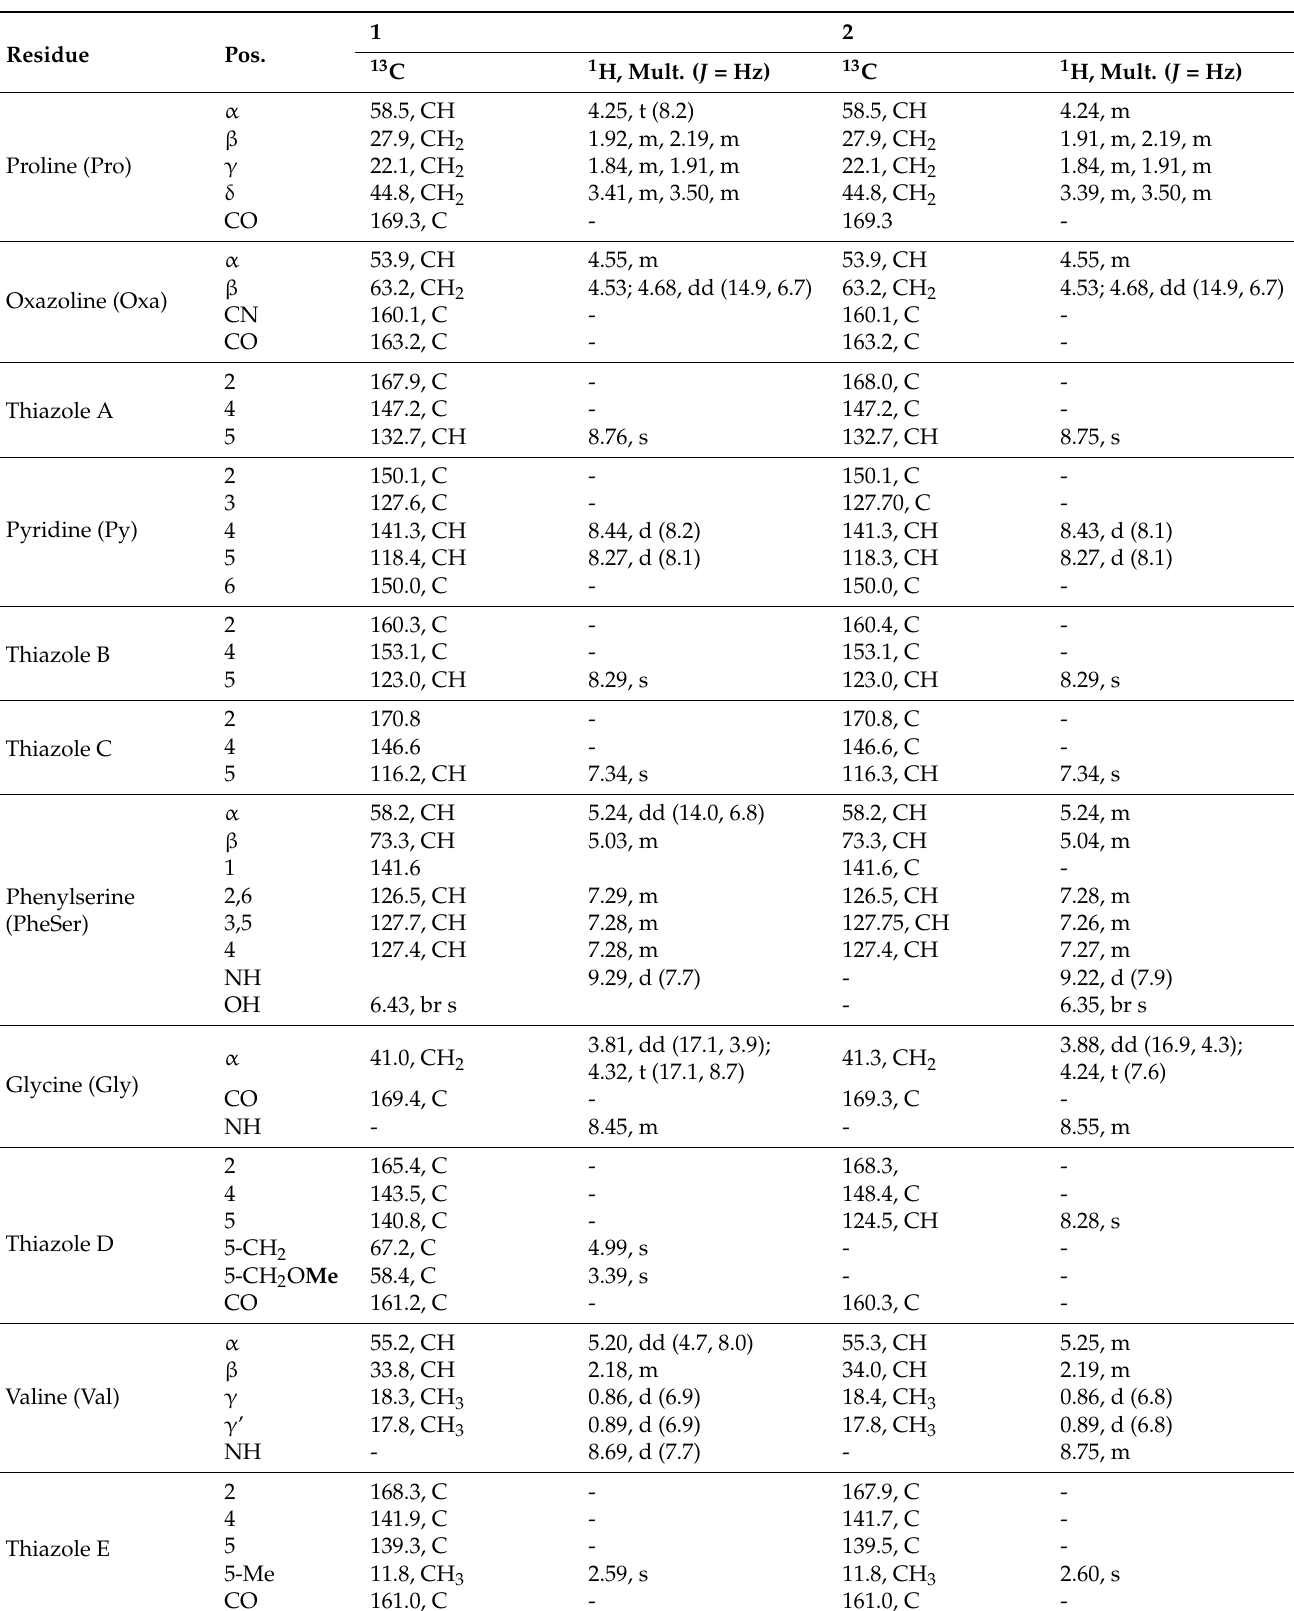
Table 1. NMR spectral data of thiopeptides 1 and 2